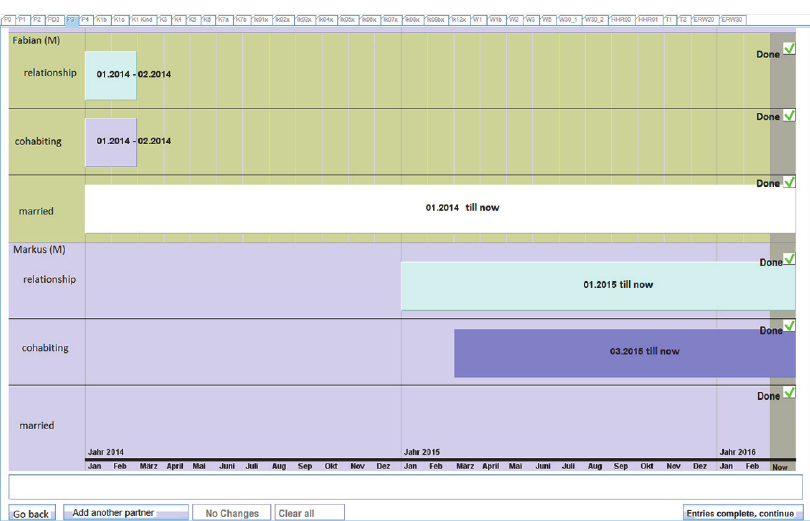
Partnership calendar containing two relationships: the respondent was married and living together with her partner at the time of the previous interview, is now still legally married but lives together with a new